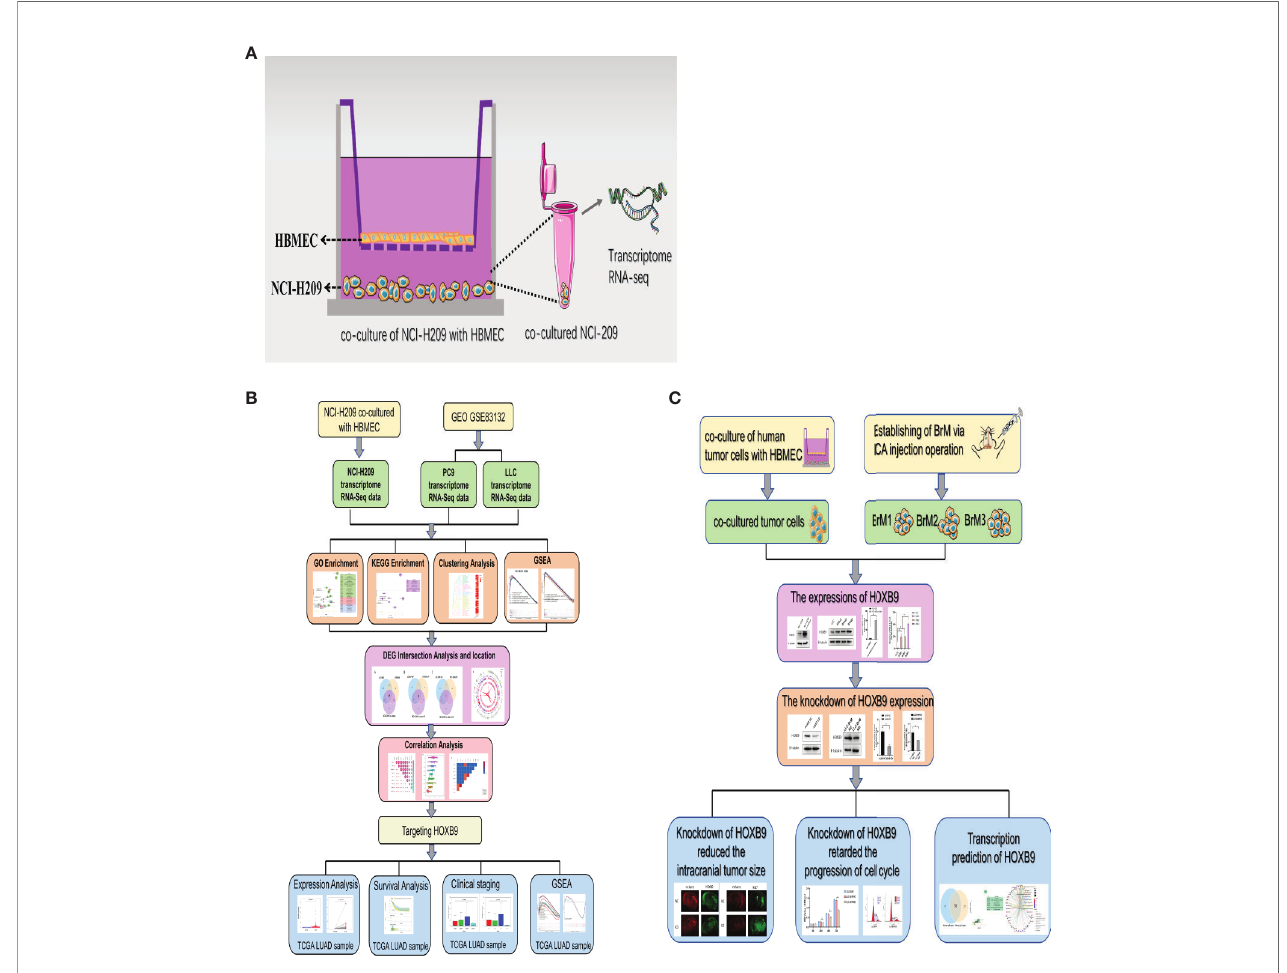
FIGURE 1 | Work fl ow of this study. (A) Schematic diagram of the in vitro co-culture system. (B) Work fl ow process of the bioinformatic analysis. (C) Work fl ow of the